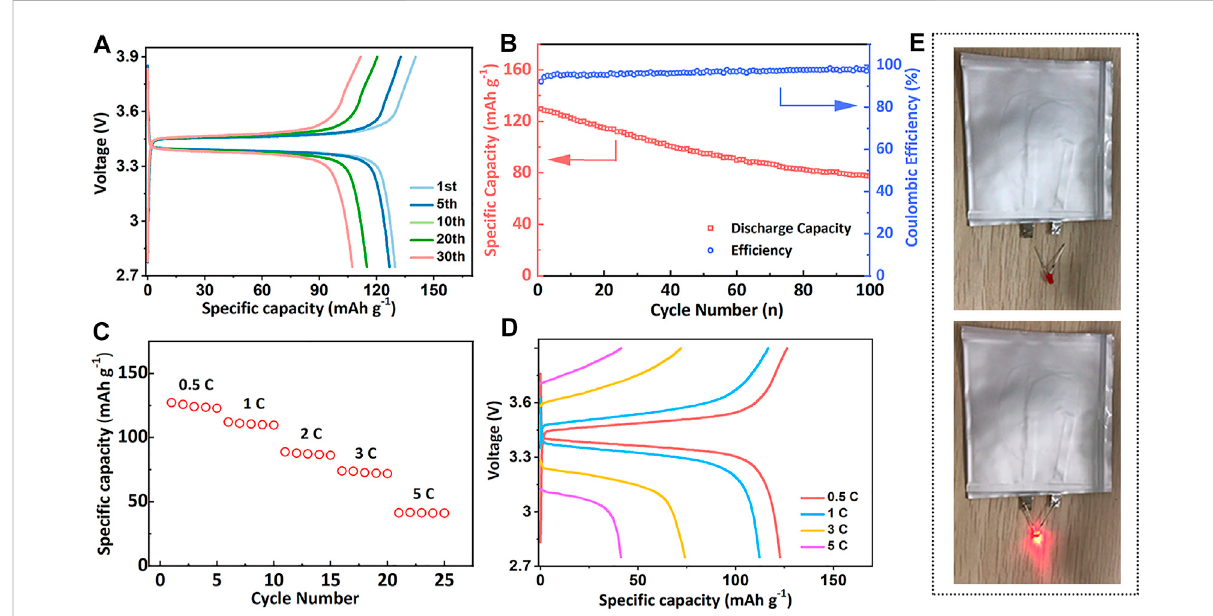
FIGURE 4 (A) The charge-discharge curves and (B) the cycling performance of the Li/PLM-2/LFP full cell at 0.2 C. (C) The rate performance and (D) the corresponding charge-discharge curves of the Li/PLM-2/LFP at 0.2 C. (E) The photos of lighted LED lamp by a PLM-2 based pouch